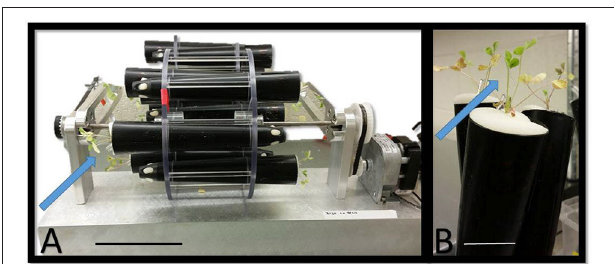
FIGURE 1 | (A) Image of the two-dimensional clinostat used in these studies. (B) Vertical gravitational controls of seedlings transplanted into cone-tainers. Arrows indicate newly transplanted 14-days-old seedlings. (A) Scale bar = 10.5cm. (B) Scale bar = 3.0cm.